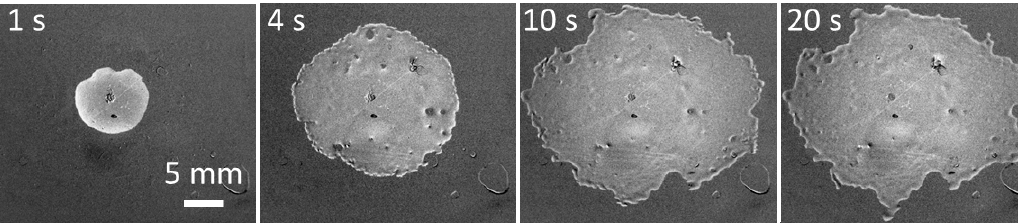
Figure 4. Spreading patterns formed by a 5 μ L drop of 1.25 g/L solution of BT-278 in water on PE substrate.